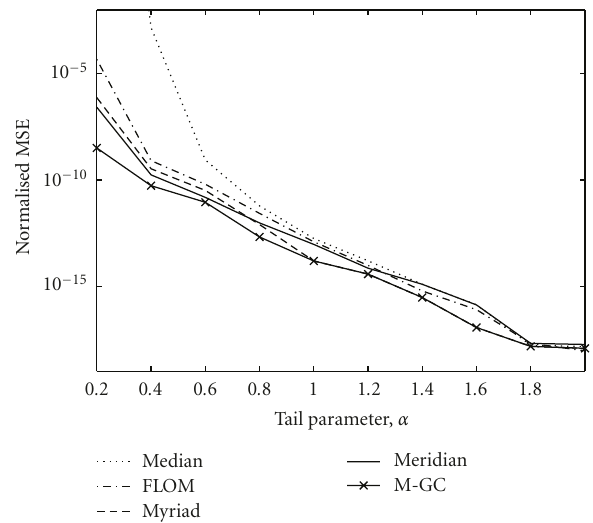
Figure 5: Power line communication enhancement. MSE for di ff erent filtering structures as function of the tail parameter α